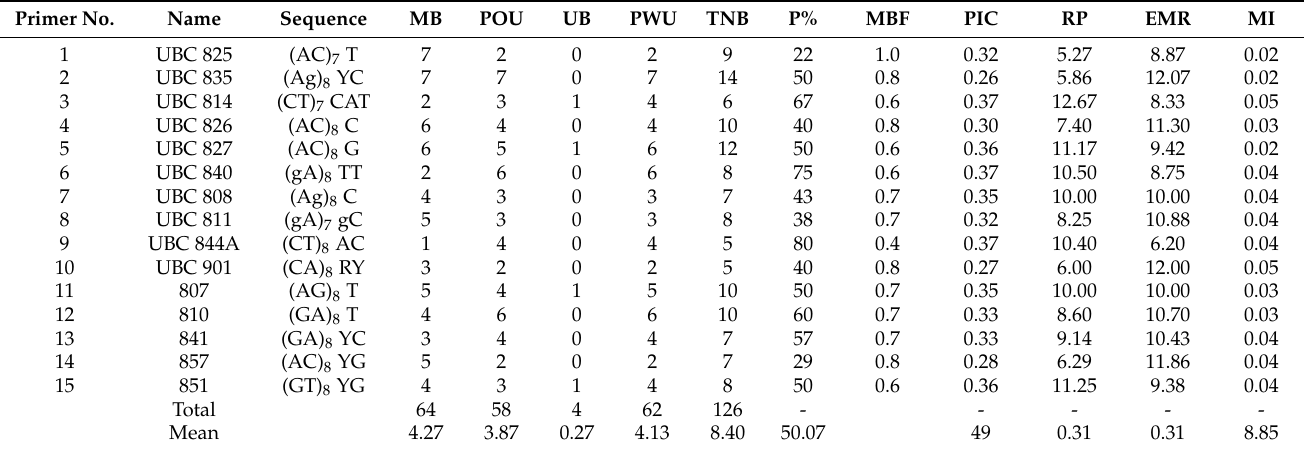
Table 2. ISSR marker profiles for 15 Egyptian six-rowed barley cultivars. Primer